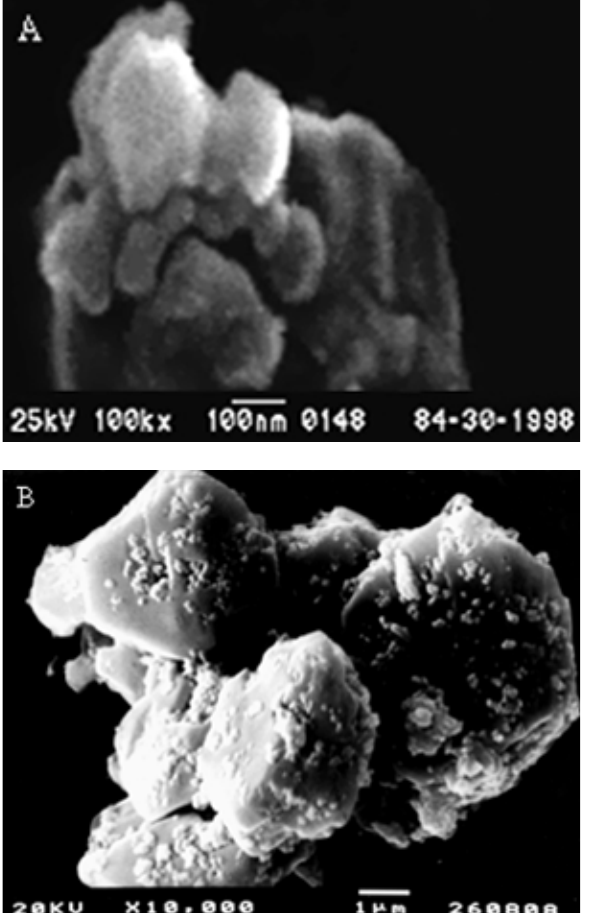
Figure 1. SEM micrographs obtained for: a) NM particles, b) NM-lead oxalate co-precipitate.